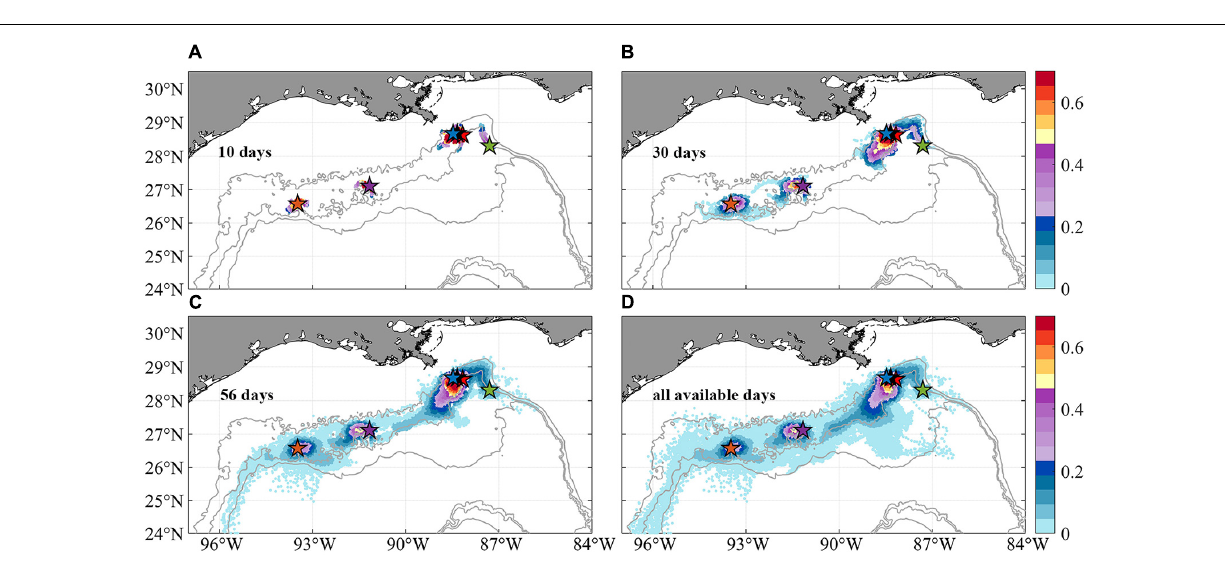
area of interest. Particles displaced in the vertical direction by more than 800 m depth are discarded ( ∼ 20% of all particles and mostly ending in very deep water). For all cases, high KDE